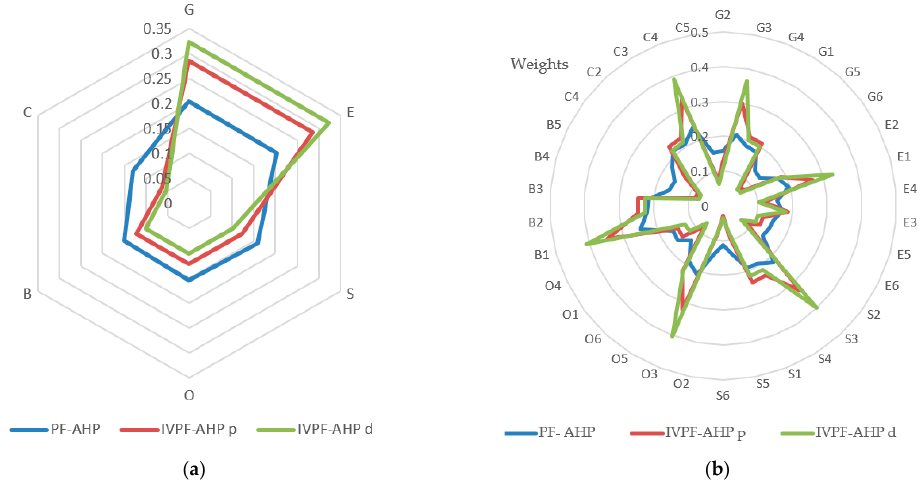
Figure 6 gives a graphic representation of the weights of criteria and sub-criteria. It can be seen that the weight values of the proposed IVPF-AHP method (IVPF-AHP p) given in Section 2.2.4 are between the PF-AHP method and IVPF-AHP method, with differences (IVPF-AHP d) given in Section 2.2.3.